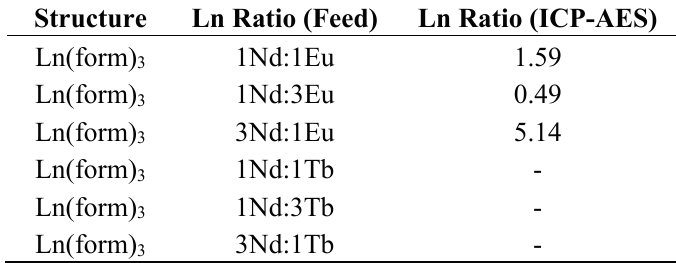
Table 3. The reactants used within the combined Nd/Ln(form) 3 MOF syntheses (0.5 mmol Nd initial